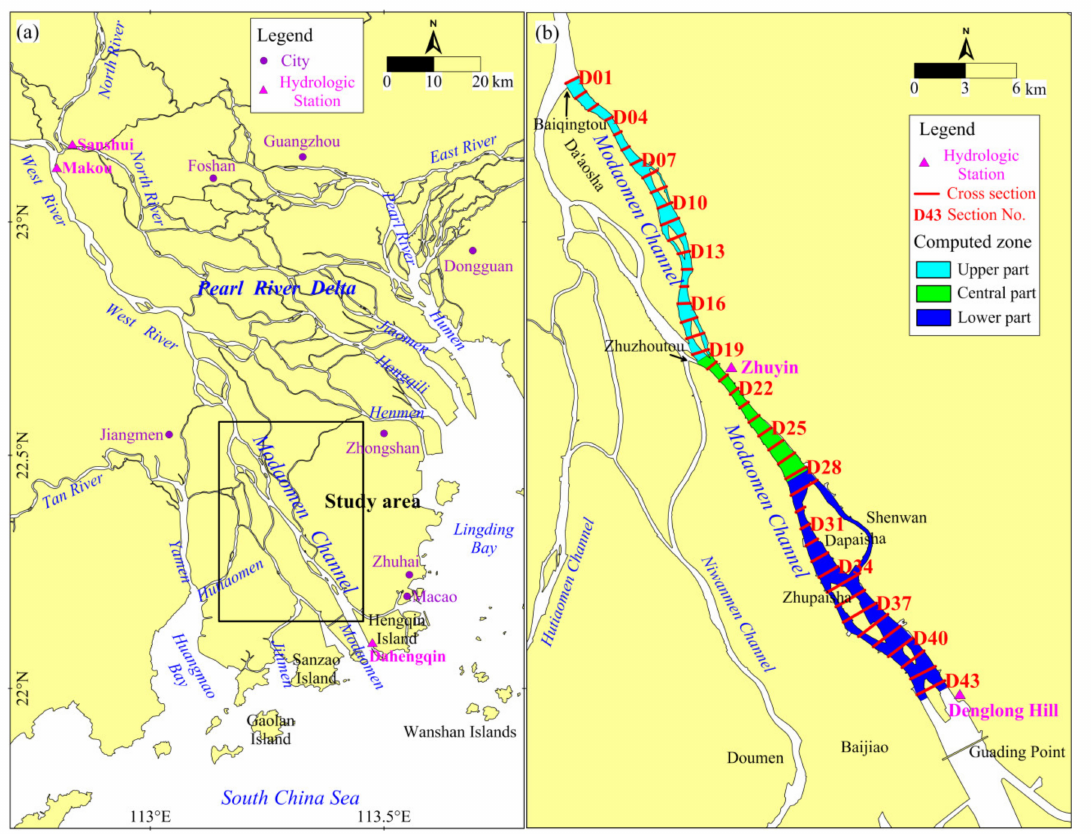
Figure 1. Sketch map of the Pearl River Delta ( a ) and Modaomen Channel ( b ), showing the cross- sections used for bathymetric